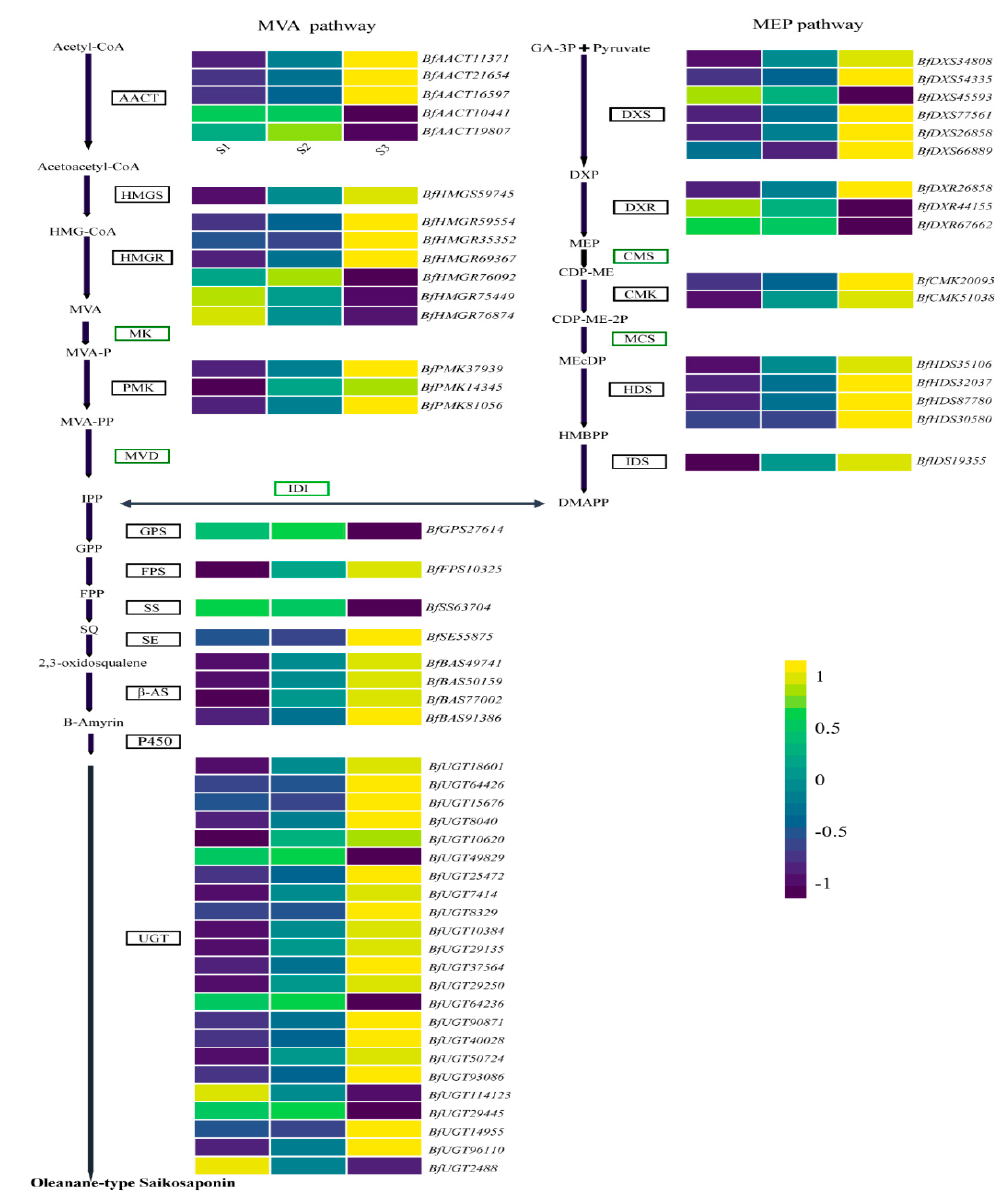
Figure 3. Differential expression of candidate genes of saikosaponin biosynthesis route among S1, S2, and S3. HMG − CoA: 3 − hydroxy − 3 − methy − lglutaryl − COA; MVA − P: 5 − phosphoevalonate; MVA − PP: 5 − pyrophosphoevalonate; DXP: 1 − deoxyxylulose 5 − phosphateuvate; CDP − ME: methylerythritol cytidyl diphosphate; CDP − ME − 2P: 4 − diphosphocytidyl − 2 − C − methyl − D − erythritol; MEcDP: 2 − C − methyl − D − erythritol − 2,4 − cyclodiphosphate; HMBPP: 4 − hydroxy − 3 − methyl − butenyl − 1 − diphosphate.